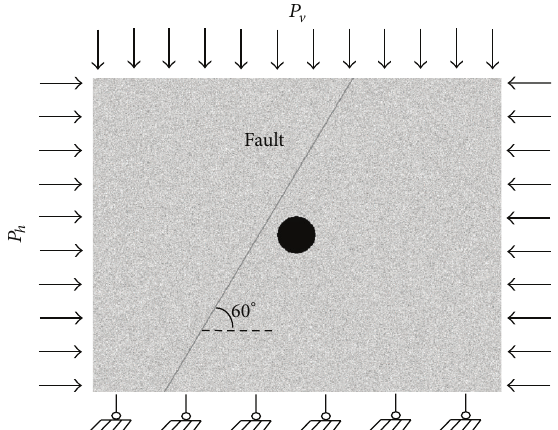
Figure 12: Numerical model of the tunnel